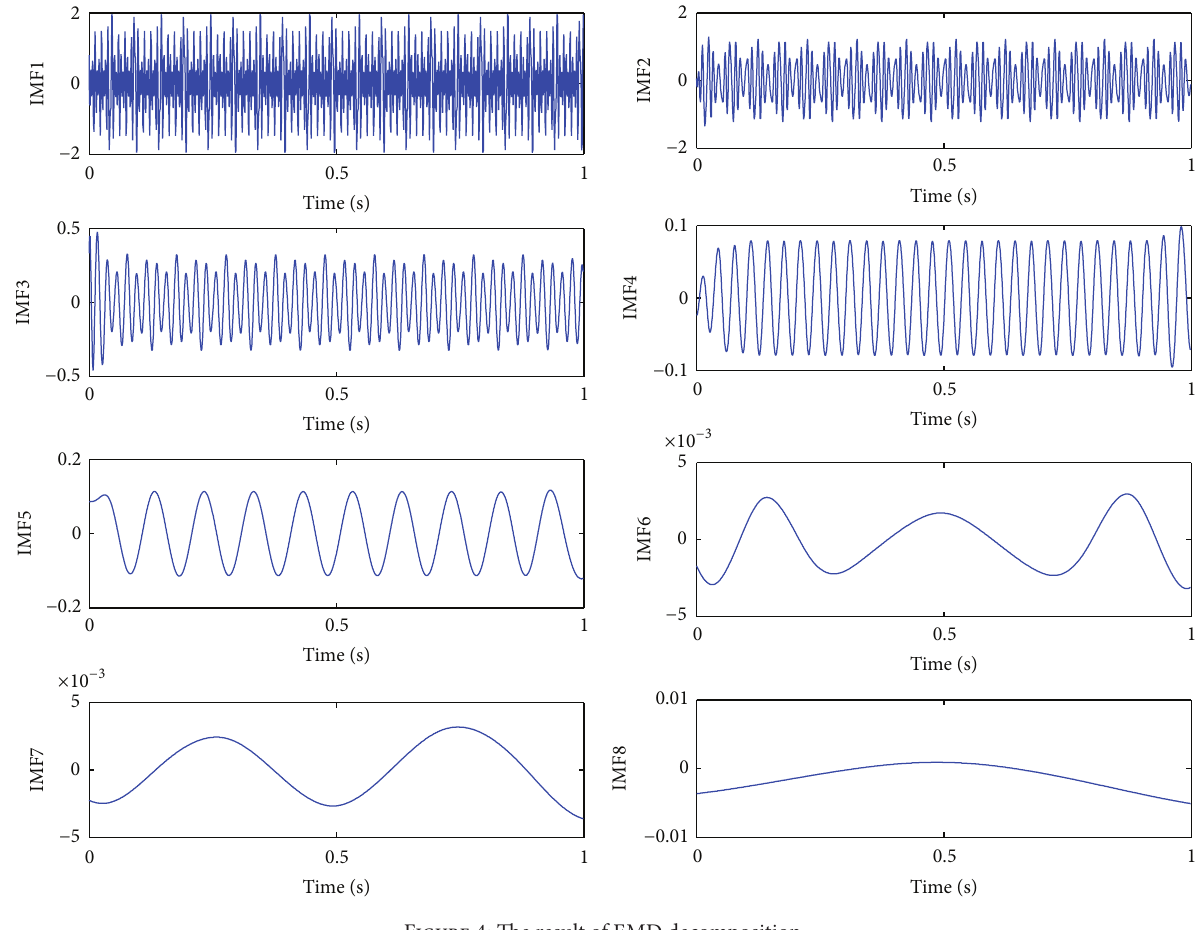
Figure 4: The result of EMD decomposition. Table 3: The experimental parameters and fault